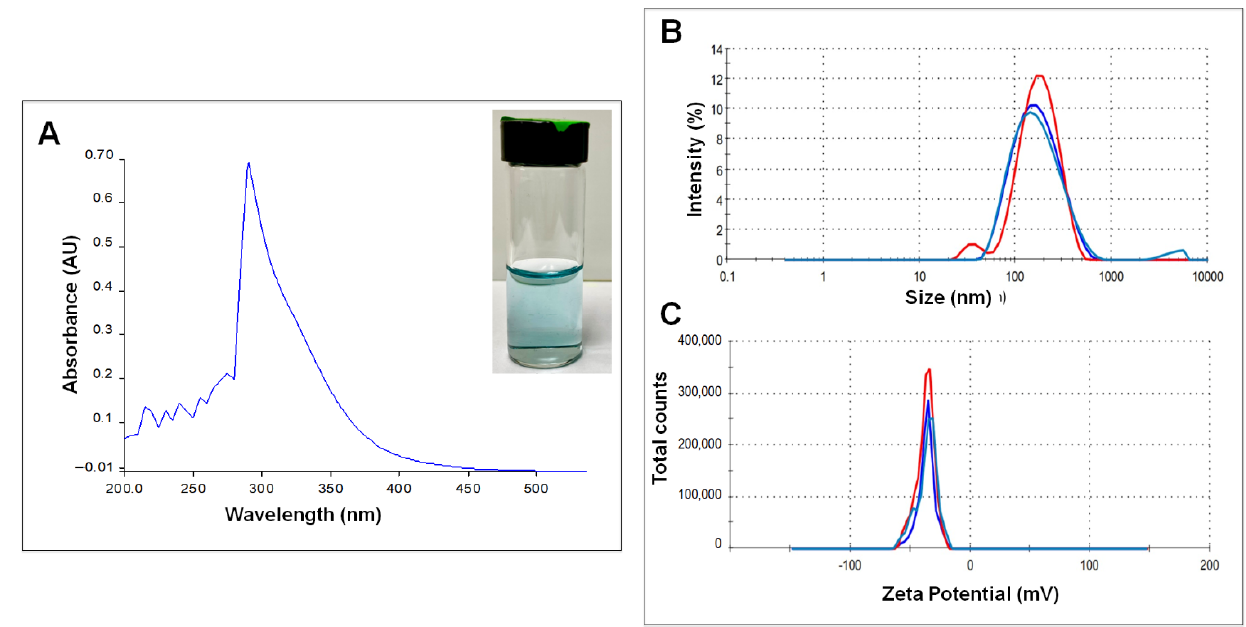
Figure 1. ( A ) Absorbance curve of copper oxide nanoparticles, ( B ) hydrodynamic diameter, ( C ) Zeta Potential. The inset in ( A ) shows the newly synthesized CuONPs.